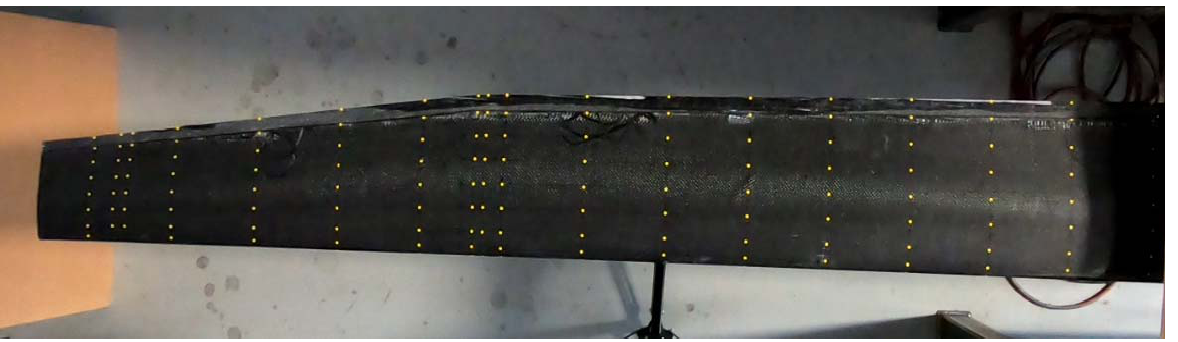
Figure 7. Wing sections discretized along the wingspan using sticker dots.